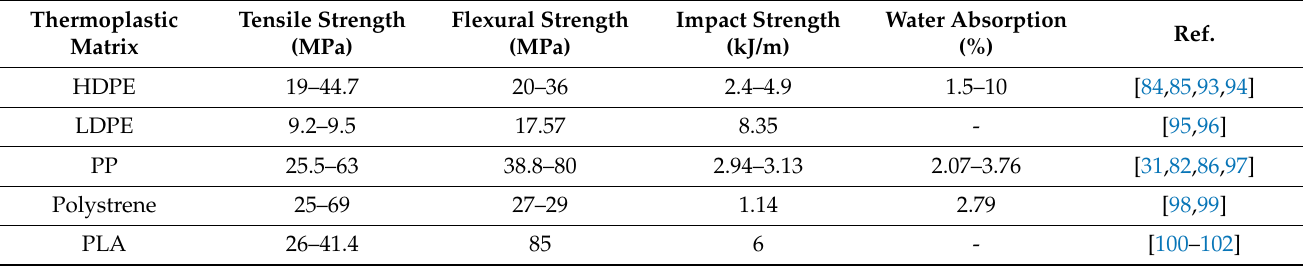
Table 7. Mechanical and physical properties of bamboo-reinforced thermoplastic